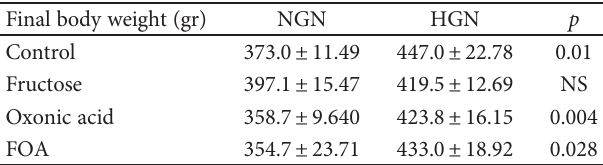
Table 1: Final body weight between normogonadic and hypogonadic animals.